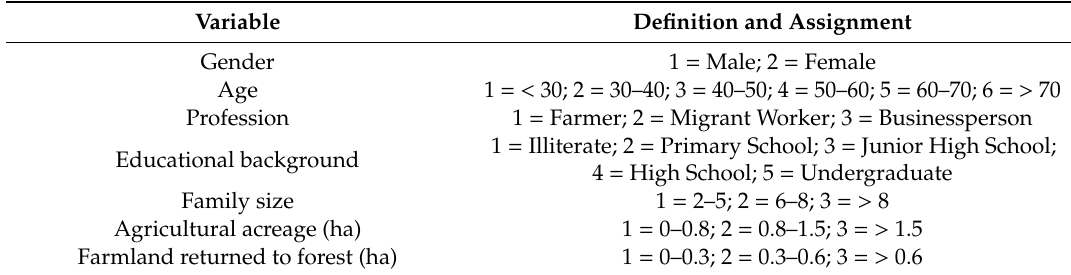
Table 3. Explanation of